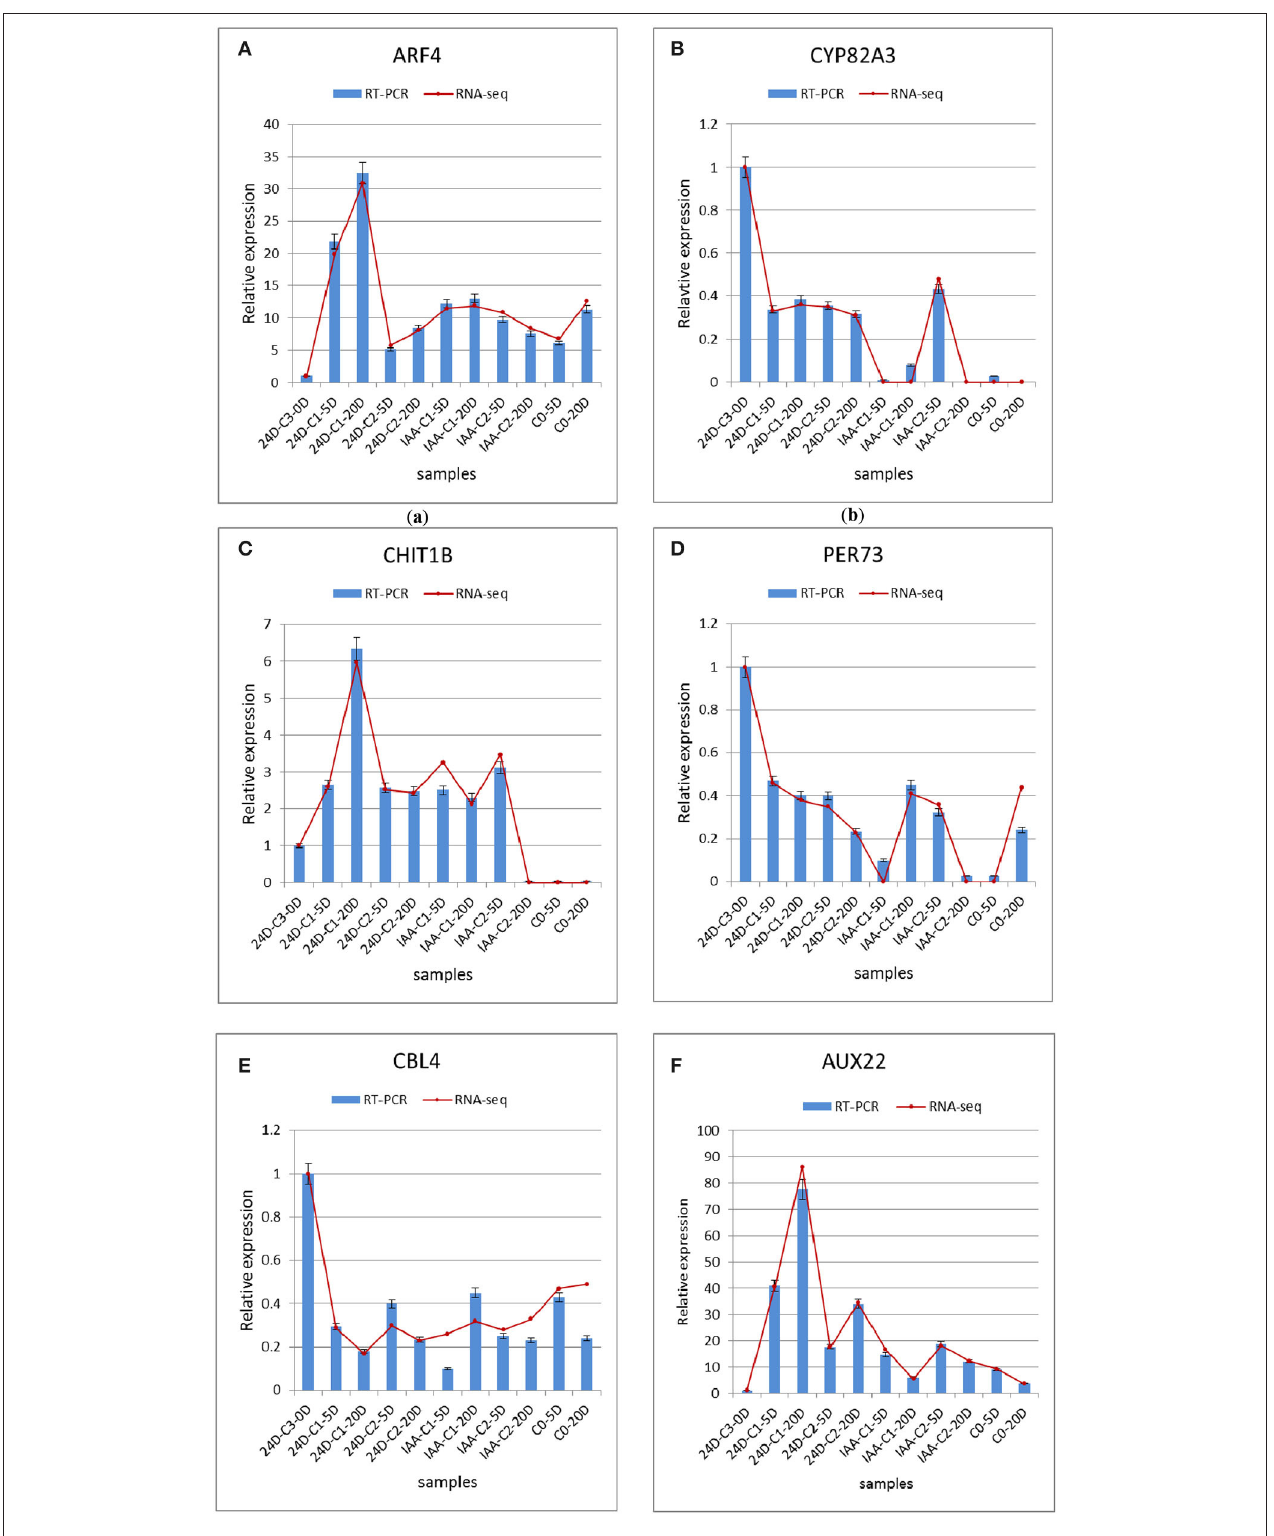
FIGURE 8 | Comparison and confirmation of the RNA-seq data with qRT-PCR. (A–F) Relative expression of DEGs selected by comparative transcriptome induced by IAA and 2,4-D. Bars represent SD, and gene abundance was calculated relative to the GhUB7 expression level. IAA, indole acetic acid; 24D, 2,4-dichlorophenoxyacetic acid; C0, 0mg L − 1 ; C1, 0.025mg L − 1 ; C2, 0.05mg L − 1 ; C3, 0.1mg L − 1 ; 5D, 5 days’ treatment; 20D, 20 days’